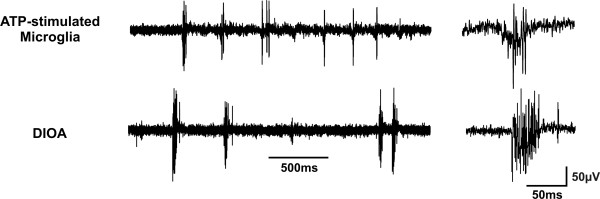
Stimulated microglia or disruption of chloride homeostasis provoke the occurrence of spontaneous bursts of activity in lamina I projection neurons. Continuous records showing the appearance of spontaneous bursts of activity in lamina I projection neurons after local administration of ATP-stimulated microglia or DIOA. The bursts were comparable to those observed in lamina I neurons from nerve-injured rats (see Fig. 3). Such burst were virtually absent in control conditions even after several hours of recording. The insets on the right show example bursts on a faster time scale.